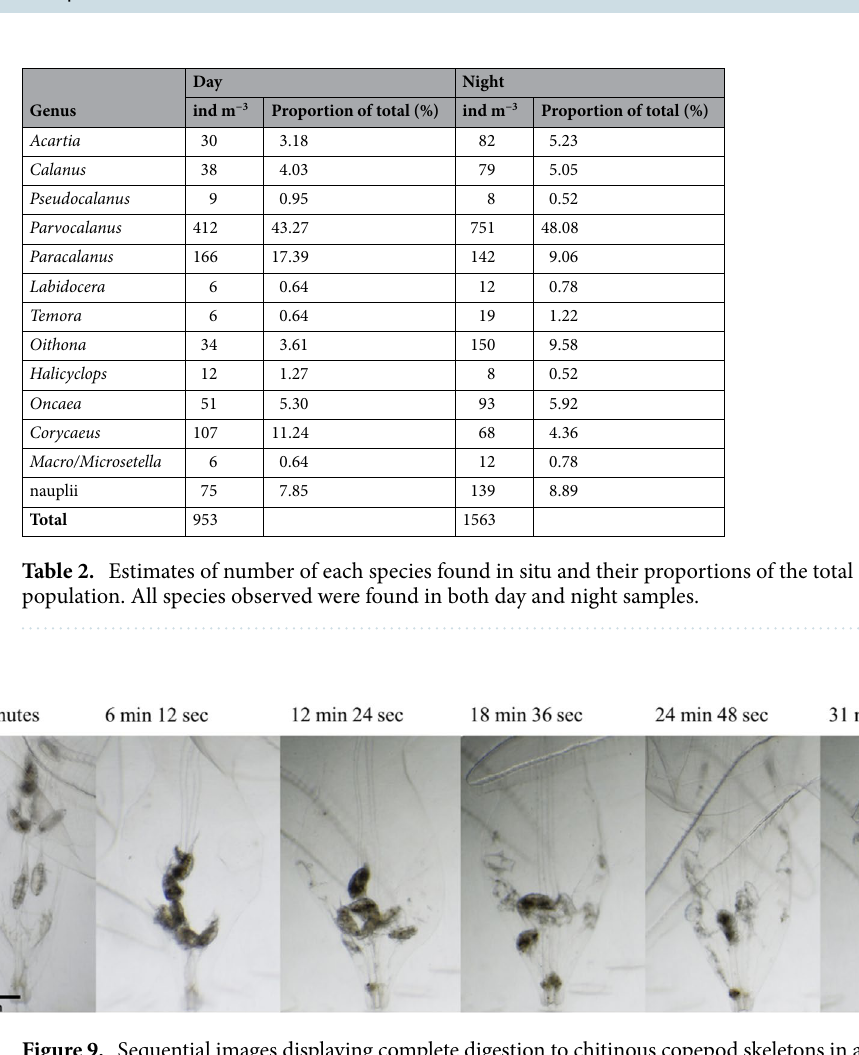
Figure 9. Sequential images displaying complete digestion to chitinous copepod skeletons in an Ocyropsis spp. individual. Scale bar in first image represents 5 mm.